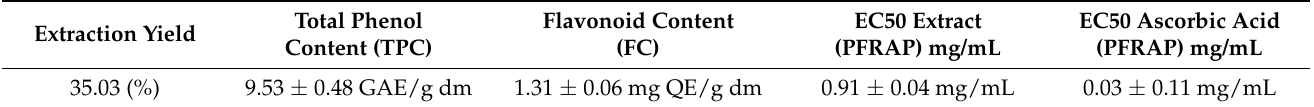
Table 1. Extraction yield, contents on total phenols (TPC) and flavonoids (FC) and antioxidant capacity of ethanolic extract from Anacyclus clavatus flowers. Values are expressed as the means ±